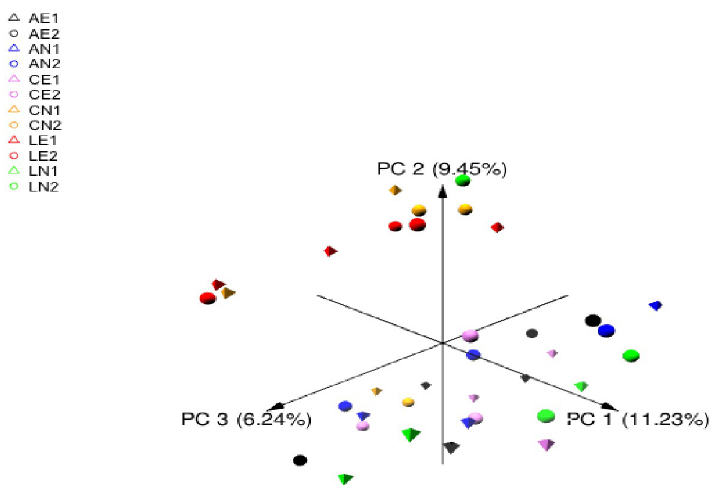
Fig 1. Principal coordinate analysis; PCoA of attached bacterial community based on Bray-Curtis dissimilarity across extracted and non-extracted plants in the rumen of camel. AE1 for extracted atriplex at 6h, AE2 for extracted atriplex at 12h, AN1 for non-extracted atriplex at 6h, AN2 for non-extracted atriplex at 12h. Also, CE1 for extracted acacia at 6h, CE2 for extracted acacia at 12h, CN1 for non-extracted acacia at 6h, CN2 for non-extracted acacia at 12h. Moreover, LE1 for extracted leucaena at 6h, LE2 for extracted leucaena at 12h, LN1 for non-extracted leucaena at 6h, LN2 for non-extracted leucaena at 12h.